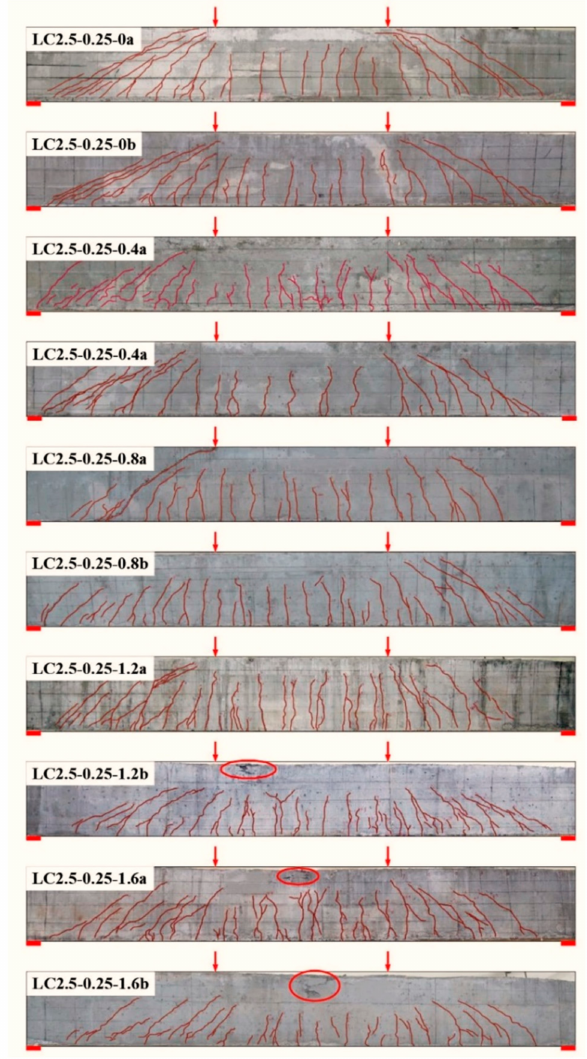
Figure 3. Crack distribution and failure mode of test beams. For test beams LC2.5-0.25-0a/b without steel fiber reinforcement, one or two main diagonal cracks appeared on the shear span, and the shear failure with wider diagonal cracks took place. With the increasing volume fraction of steel fibers v f , the number of shear cracks increased, the diagonal cracks slowly extended, and the diagonal angle of the main shear crack tended to be reduced slightly. Meanwhile, the shear-compression zone existed clearly with uncrack depth near loading points. The shear failure with smaller diagonal cracks took place on test beams with v f ≤ 0.8%, and the failure in the shear